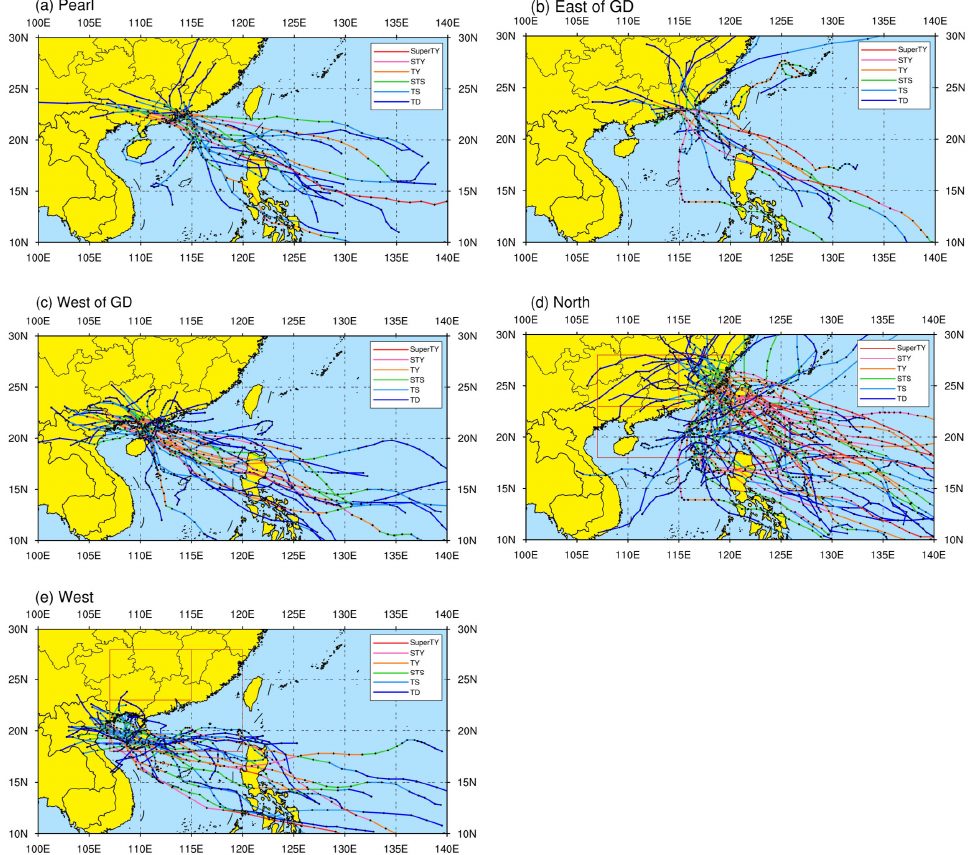
Figure 3. Typhoon tracks of five classifications from 1998–2019. Figure 4 illustrates the spatial distributions of the average cumulative precipitation during 24 h before through 24 h after the typhoons made landfall in different regions. For the typhoons that landed on the Pearl River Delta region, the corresponding high values of precipitation appeared in the coastal areas of the Pearl River Delta region and the western regions of Guangdong province, and the areas with less precipitation were mainly located in the northern and northeastern regions of Guangdong. For the typhoons that landed on eastern Guangdong, the corresponding high values of precipitation appeared in the Pearl River Delta region and the eastern regions of Guangdong province. For the typhoons that landed on western Guangdong, the corresponding high values of precipitation appeared in the western regions of Guangdong province, and the areas with less precipitation were mainly located in the northern parts of east Guangdong. For the non-landing typhoons that moved northward, major precipitation zones appeared in a small part of eastern Guangdong, with the values of precipitation being apparently lower than corresponding high precipitation values that were caused by the landfall typhoons. For the typhoons that moved westward, the related high precipitation appeared in Jiangmen city and small parts of Zhanjiang city. Therefore, when typhoons make landfall in different areas of Guangdong, the corresponding areas of high precipitation differ as expected, and thus we will focus attention on the contrasting high precipitation areas that correspond to different